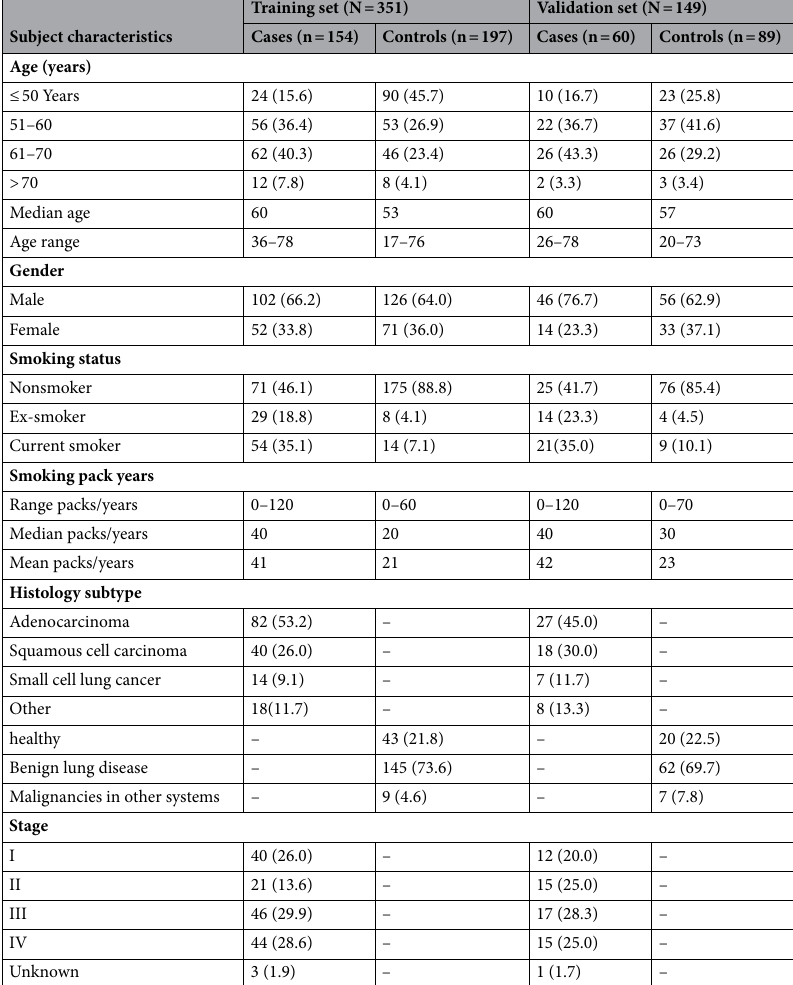
Table 1. Subject’s demographics and clinical characteristics. Benign lung diseases including pulmonary infection, sarcoidosis and bronchiectasis etc. Malignancies in other systems including thyroid carcinoma, breast cancer, osteosarcoma and esophageal